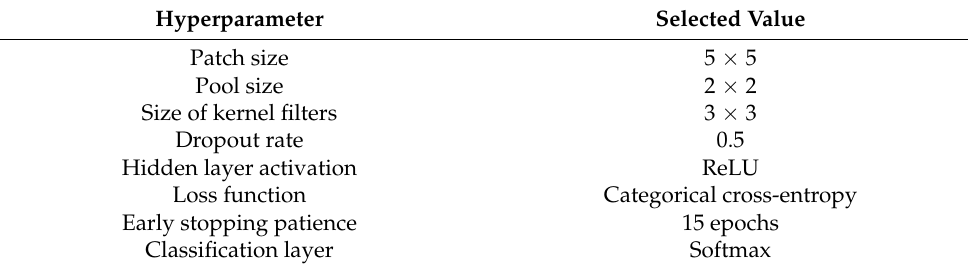
Table 4. Hyperparameters used in the base